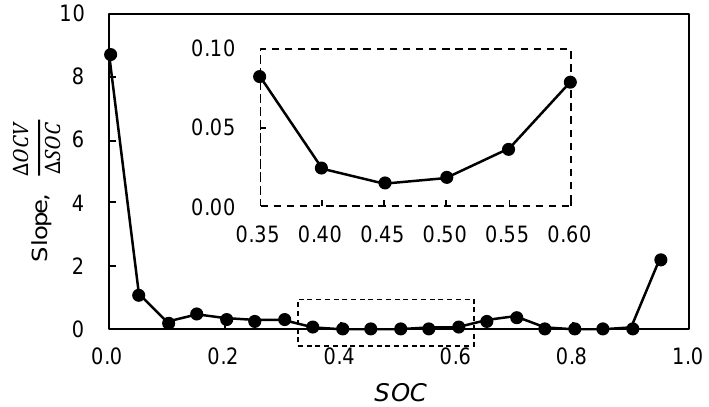
Figure 6. Slope of the linearized SOC-OCV curve.